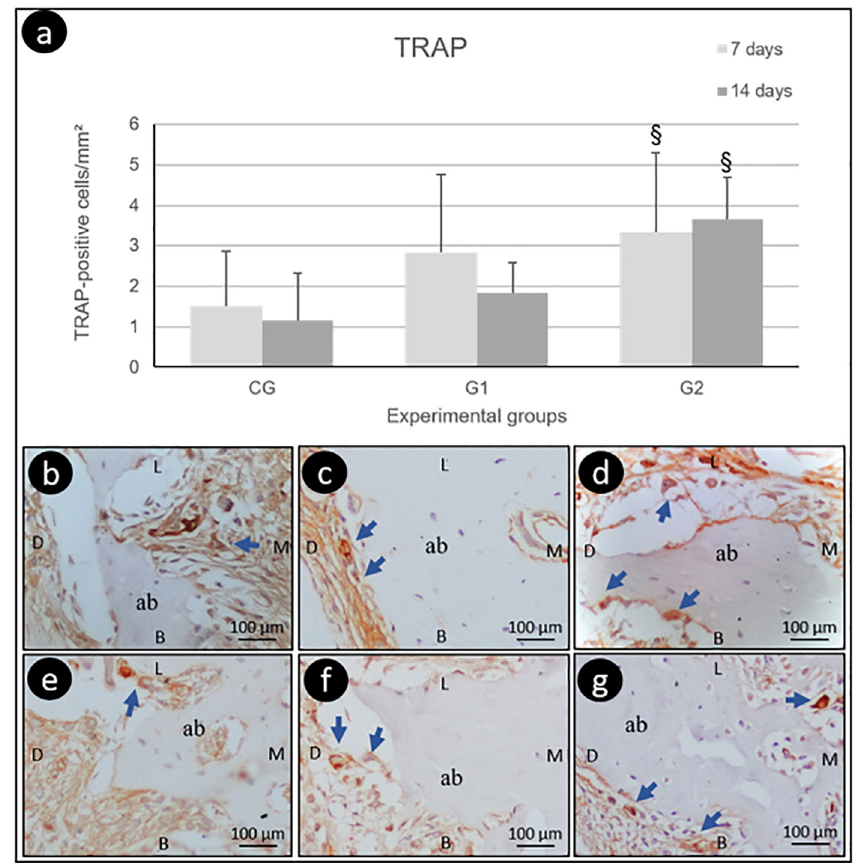
Figure 5- Mean and standard deviation of TRAP